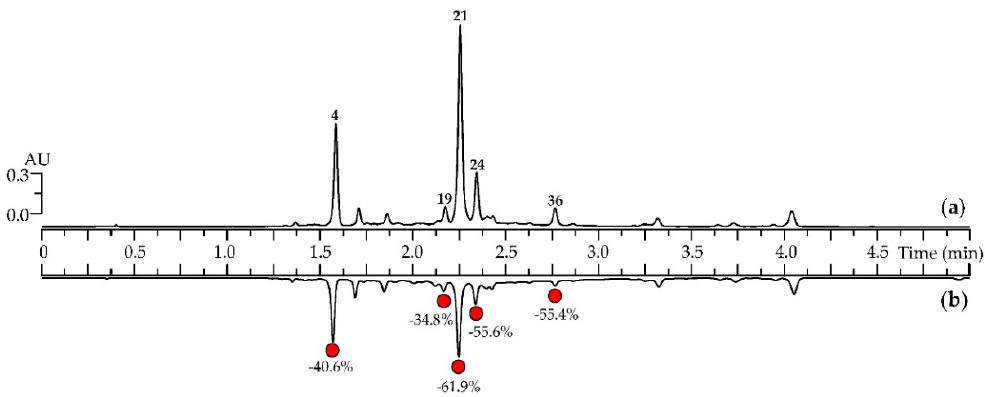
Figure 5. HPLC-DAD chromatograms (330 nm) of A. frigida herbal tea ( a ) before and ( b ) after prechromatographic reaction with DPPH • radicals. Compounds are numbered as listed in Table 1. In